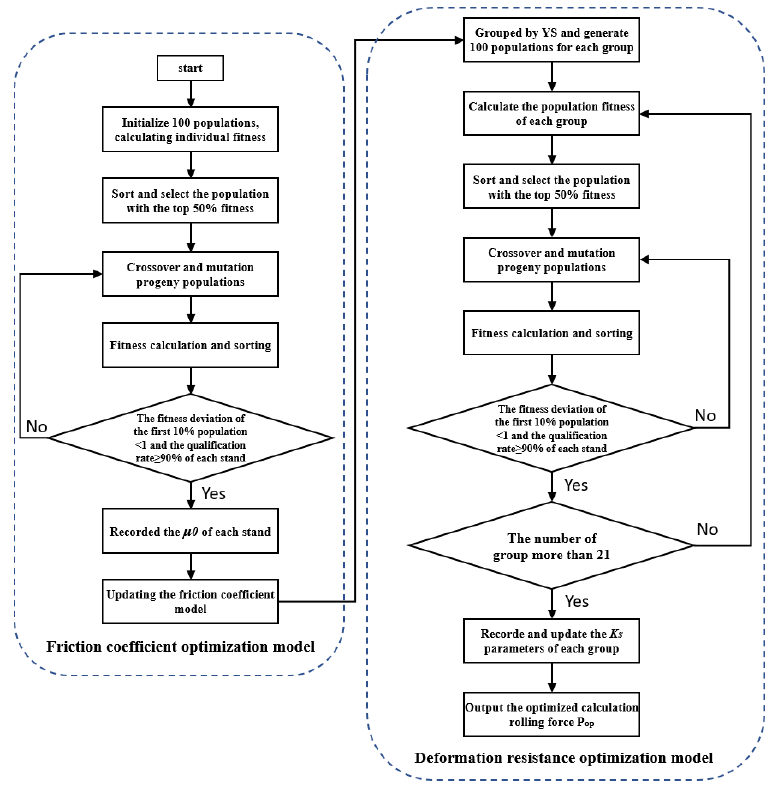
Figure 2. The calculation process of the RPFM.